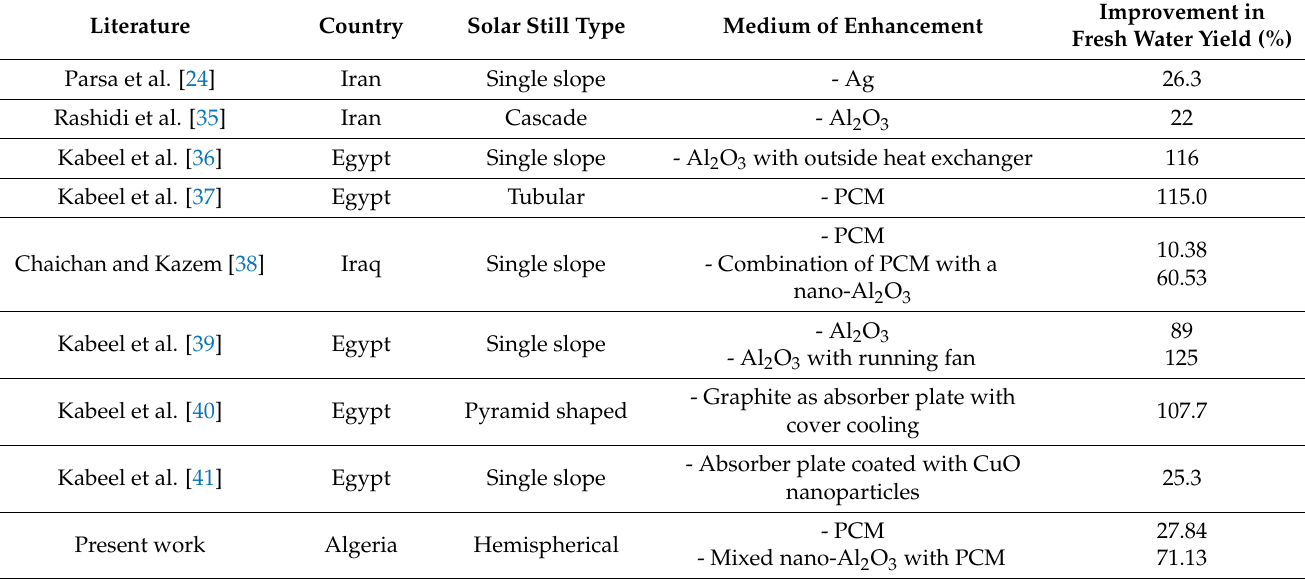
Table 6. Comparison between the daily yield enhancement of the current work and previously published